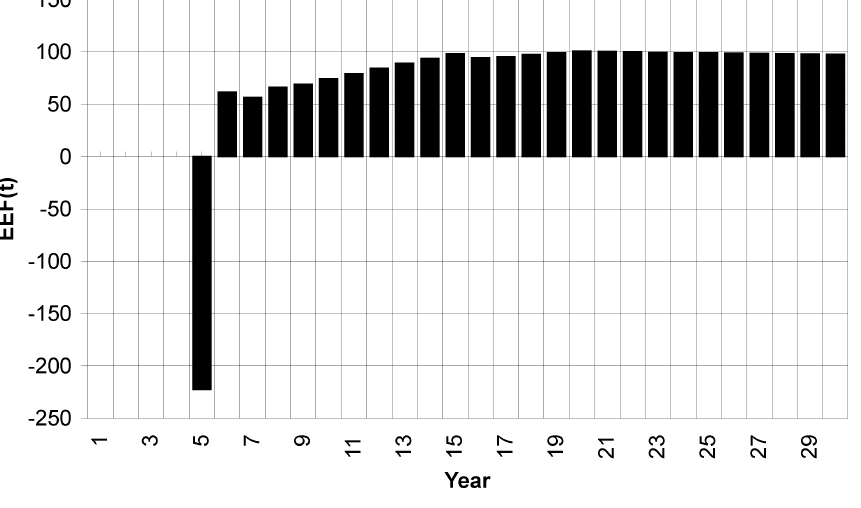
Figure 8: Development of the yearly EEF